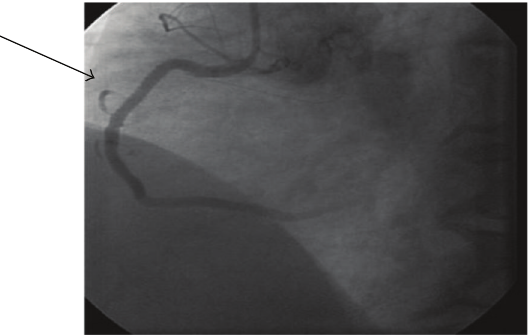
Figure 2: Post RCA stent residual showing 0% stenosis.